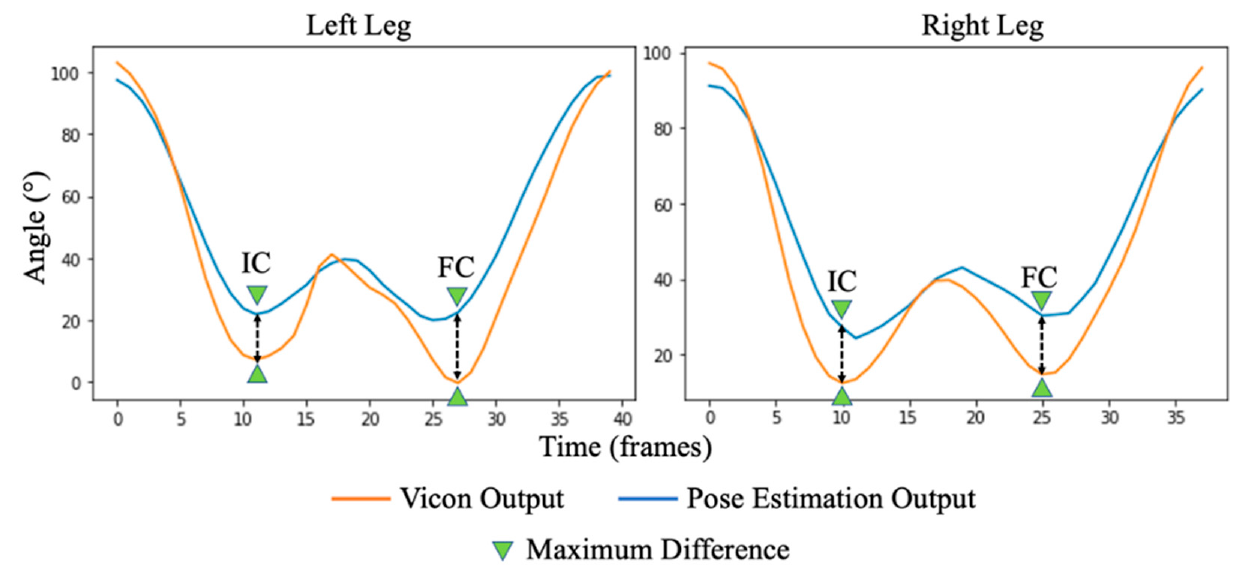
Figure 6. An illustration of the knee flexion angle of an average stride within the dataset between left and right legs. Here, it can be seen that pose estimation (orange) can closely match 3D motion tracking (blue) above ~40°; however, a maximum difference is exacerbated below ~40°, indicating pose estimation may overestimate knee flexion angles during maximum extension events (IC/FC).